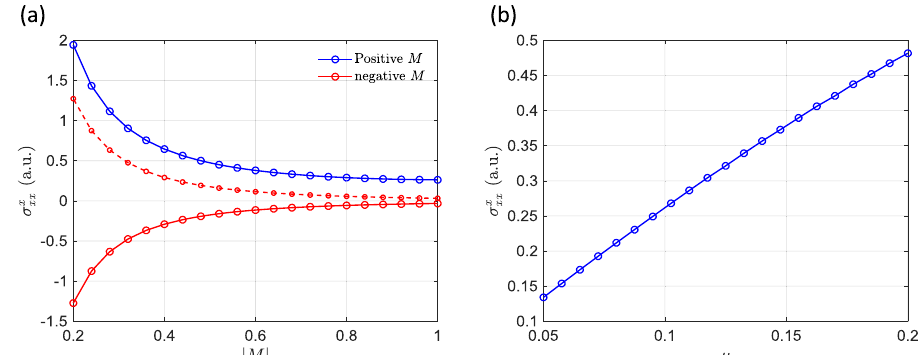
Fig. 1 Shift current conductivity of a minimal k · p model. The shift current conductivity σ x xx for the model Hamiltonian H ( k ) = d ( k ) · σ + μσ x , where d k ð Þ ¼ ½ Ak x ; Ak y ; M (cid:2) B ð k 2 x þ k 2 y Þ(cid:4) and σ = [ σ x , σ y , σ z ] are Pauli matrices. a M is varied. For positive and negative M with the same absolute value, j σ x xx j is larger when M is positive due to band inversion. A = 2, B = 1, μ = 0.1 is used. Blue and red solid curves are σ x xx for M > 0 and M < 0, respectively. For better visibility, the red solid curve is fl ipped (red dashed curve, with an extra minus sign) to be compared with the blue curve. b μ is varied. σ x xx scales approximately linearly with μ , which determines the strength of inversion symmetry breaking. A = 2, B = 1, M = 1 is